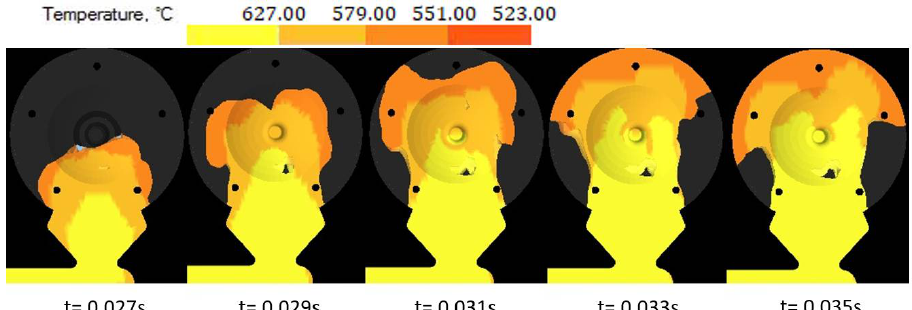
Figure 7. Formation of the melt jet outside the cores.